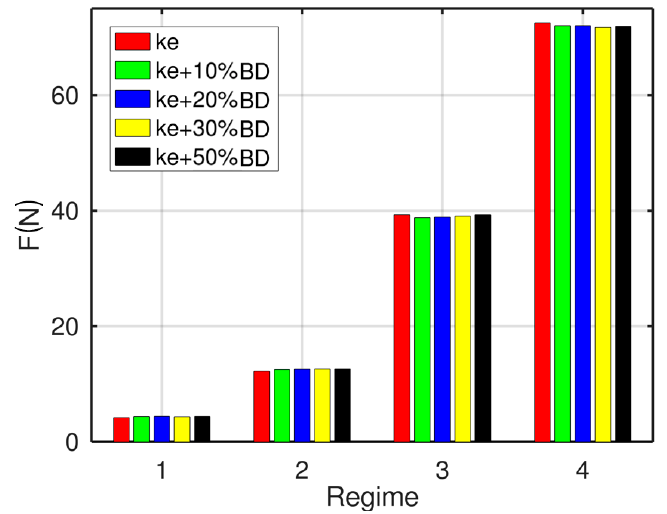
Figure 11. Variation of thrust F(N) depending on the regime and blend.